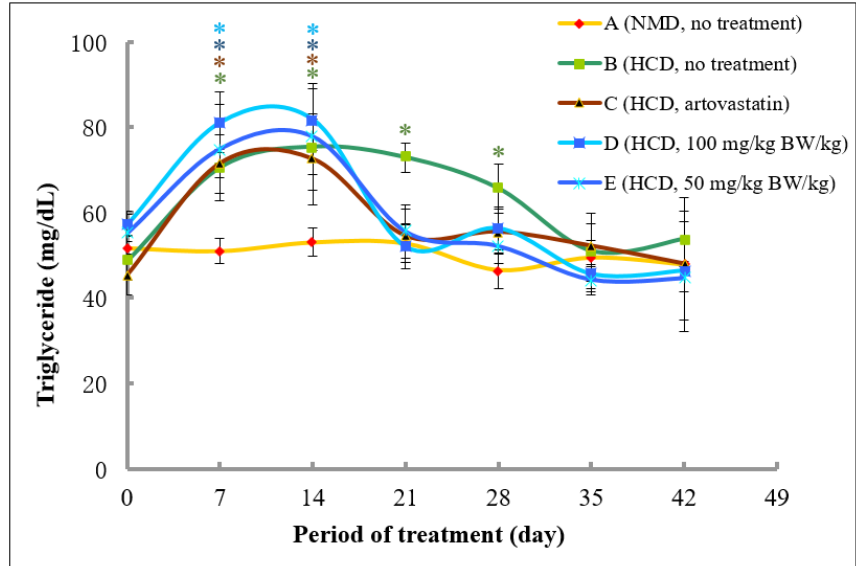
Figure 8. The changes of triglyceride (TG) levels in rats fed with normal diet throughout 42 days of the experimental period. (A) Fed with normal diet for 14 days, followed by high fat diet for another 14 days, followed by normal diet until Day 42 (B); fed with high fat diet for 14 days, followed by normal diet together with atorvastatin for another 14 days, followed by normal diet without atorvastatin until Day 42 (C); fed with high fat diet for 14 days, followed by normal diet together with 100 mg/kg of methanolic extract for another 14 days, followed by normal diet without the extract until Day 42 (D); and fed with high fat diet for 14 days, followed by normal diet together with 50 mg/kg of methanolic extract for another 14 days, followed by normal diet without the extract until Day 42 (E). * denotes significantly different as compared to untreated control rats at Day 0 (negative control) of the respective group at p < 0.05.